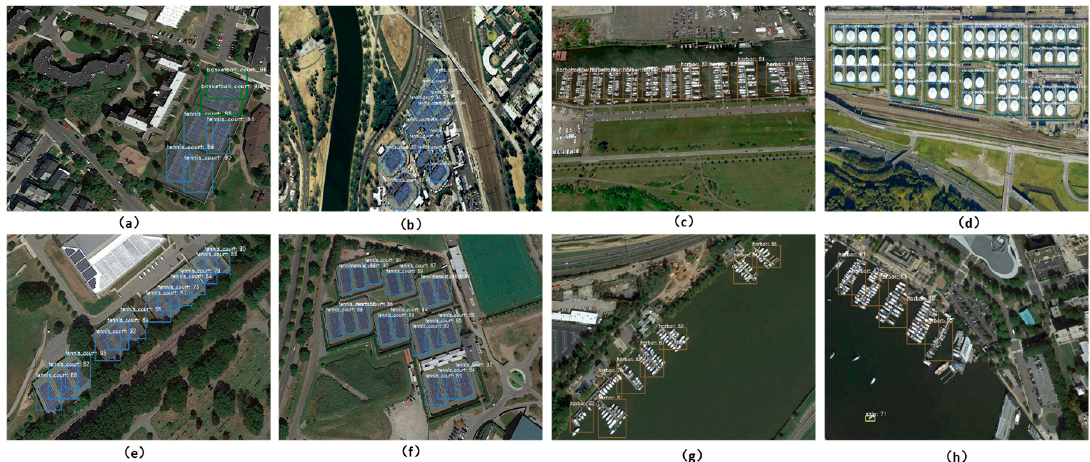
Figure 10. Detection results of dense object by proposed method. ( a ) tennis courts and basketball courts. ( b ) tennis courts. ( c ) harbors. ( d ) storage tanks. ( e ) tennis courts. ( f ) tennis courts. ( g ) harbors. ( h ) harbors.